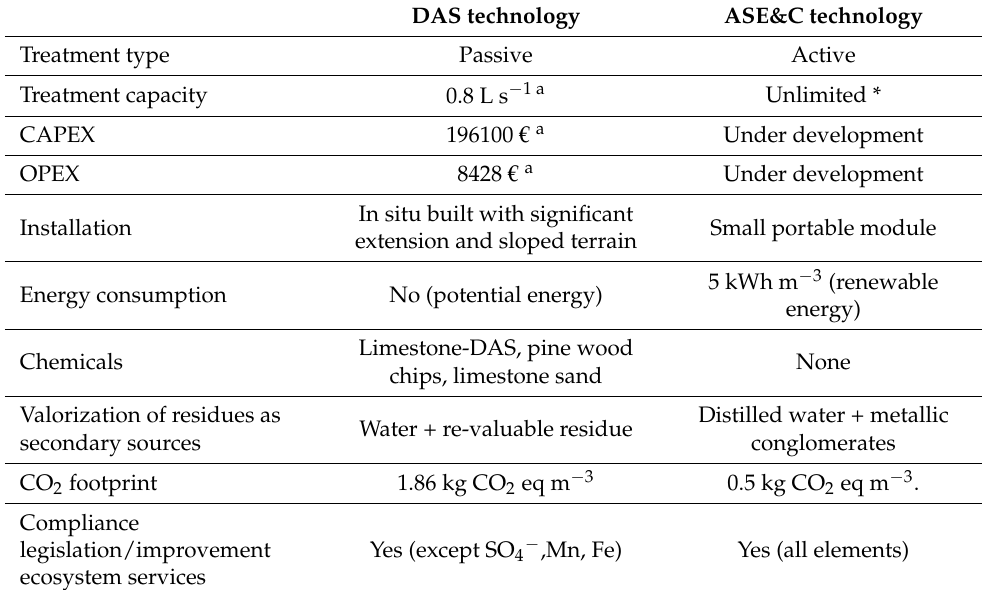
Table 2. Comparative advantages of the AMD treatment technologies: DAS and